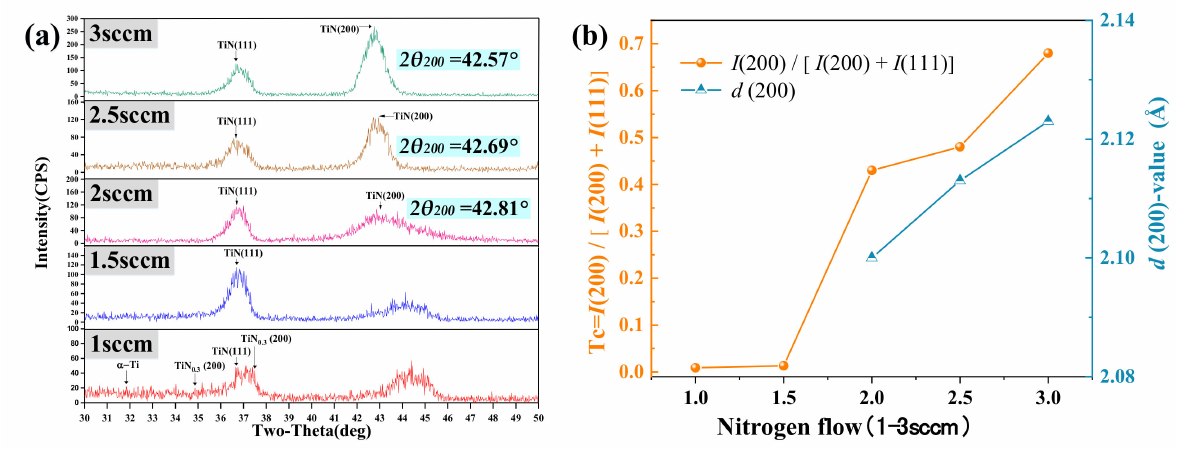
Figure 7. ( a ) The XRD image and phase composition of the TiN film are obtained at a bias of − 60 V and a nitrogen flow rate of 1–3 sccm. ( b )Effect of Nitrogen Flow on TiN(200) Peak Orientation and lattice plane distance ( d 200